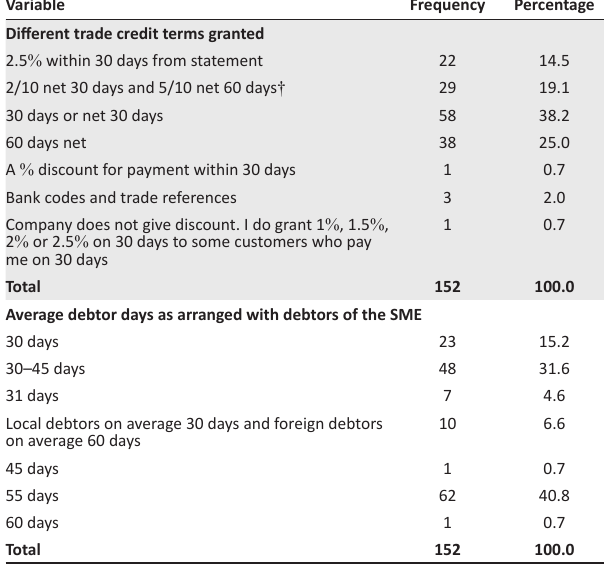
TABLE 5: Trade credit terms granted and average debtor days arranged.